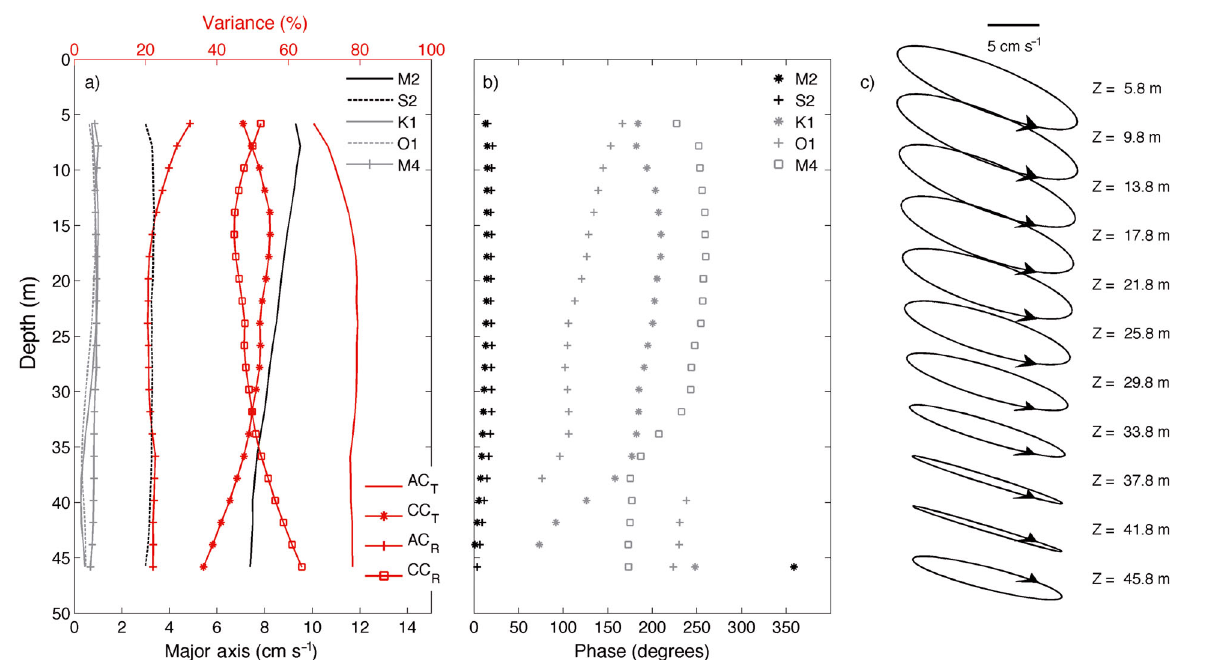
Fig. 4. (a) Vertical structure of the percentage of variance explained (red lines) by tidal along- and cross-channel currents (AC T and CC T , respectively) and detided along- and cross-channel currents (AC R and CC R , respectively), and of the ampli- tudes of the main tidal constituents (M2, S2, K1,O1, M4; black and grey lines). (b) Vertical structure of the phase of the main tidal constituents. (c) Semidiurnal tidal ellipses for M2. Caucahue Channel, 17 April to 21 July